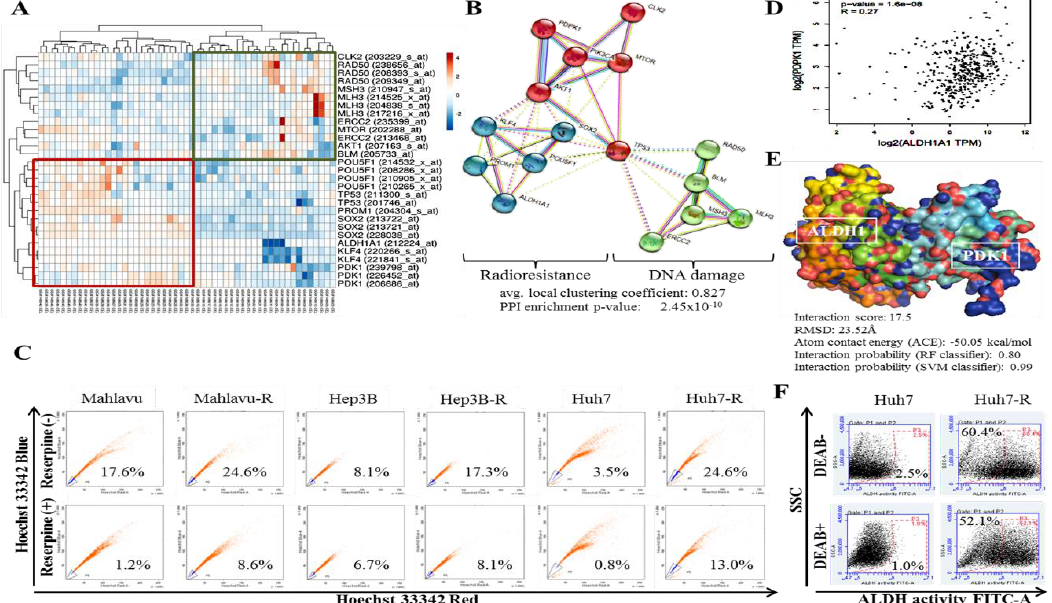
Figure 3. AberrantPDK1expressionisimplicatedintheacquisitionofradioresistanceandevasionofDNA Figure 3. Aberrant PDK1 expression is implicated in the acquisition of radioresistance and evasion of damagebyHCCcells. ( A )Heatmapofgene-setexpressionintheE-GEOD-6464, AFFY_HG_U133_PLUS_2 DNA damage by HCC cells. ( A ) Heatmap of gene-set expression in the E-GEOD-6464, data set. Rows are centered; unit variance scaling is applied to rows. All 29 rows and 53 columns were AFFY_HG_U133_PLUS_2 data set. Rows are centered; unit variance scaling is applied to rows. All 29 clustered using correlation distance and average linkage. ( B ) STRINGdb-generated visualization of rows and 53 columns were clustered using correlation distance and average linkage. ( B ) STRINGdb- generated visualization of the protein-protein interaction between PDK1/PDPK1, PI3K/AKT/mTOR signaling pathway (red nodes), CSCs markers (blue nodes) and DNA damage markers (green nodes).